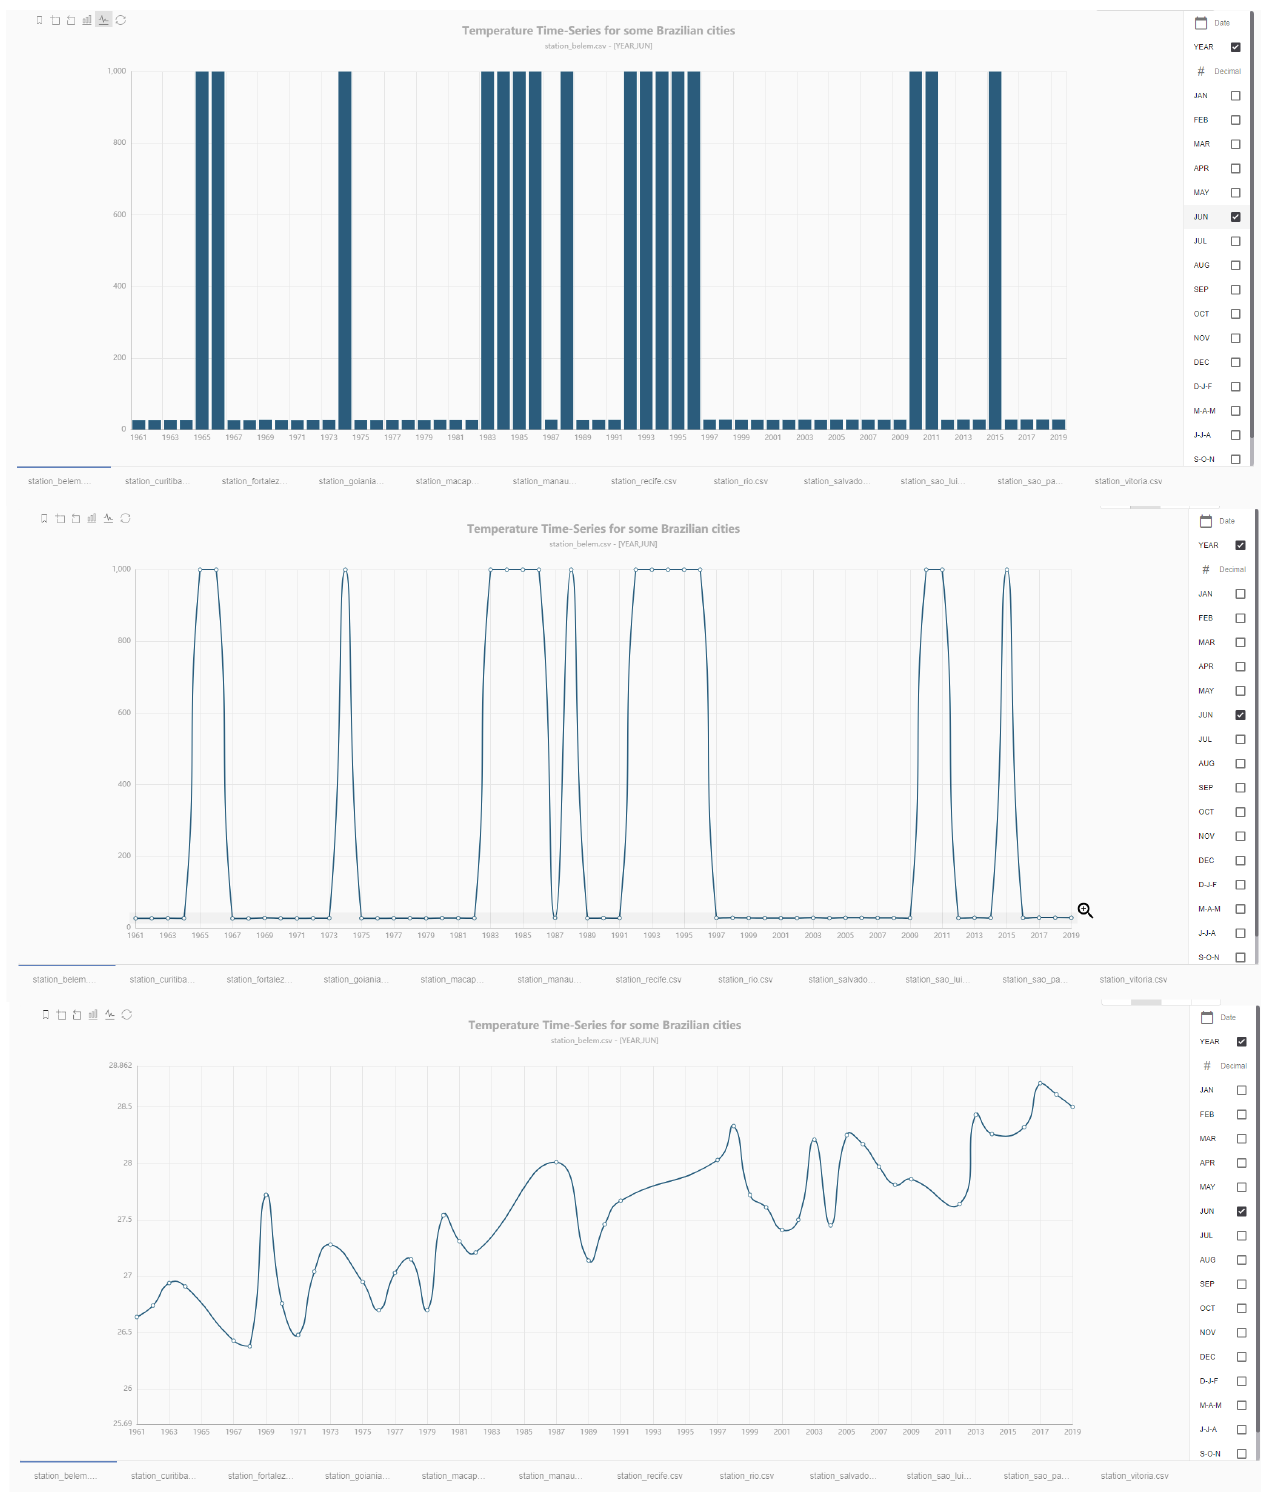
Figure 6. For the exemplary time series dataset of temperatures measured in Brazil, our system initially creates a basic histogram. Then, it advises to change the chart type to line chart (button at top left corner) and, finally, to apply a zoom in to a specific value range of the data (Y-axis: 25.6–28.8) which filters the outliers. The final view shows a visible raise in temperature over the